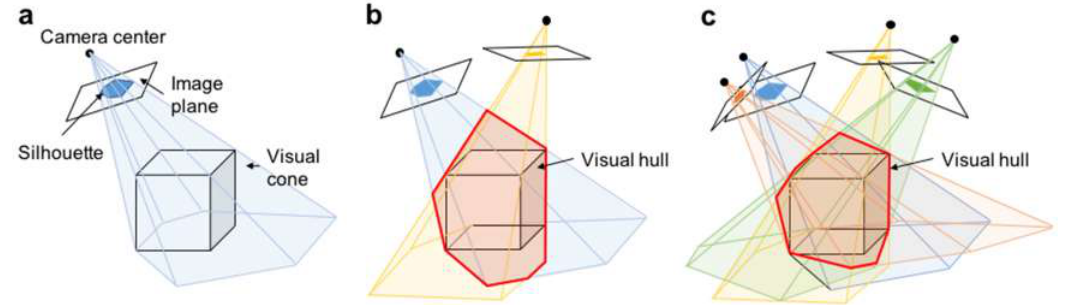
Figure 1. 3D shape reconstruction based on shape from silhouette (SFS) method. ( a ) visual cone obtained by back projection of silhouette image; ( b ) visual hull obtained by intersection of two visual cones; and, ( c ) 3D shape acquired by bounding geometry of resultant visual hull with multiple visual cones.